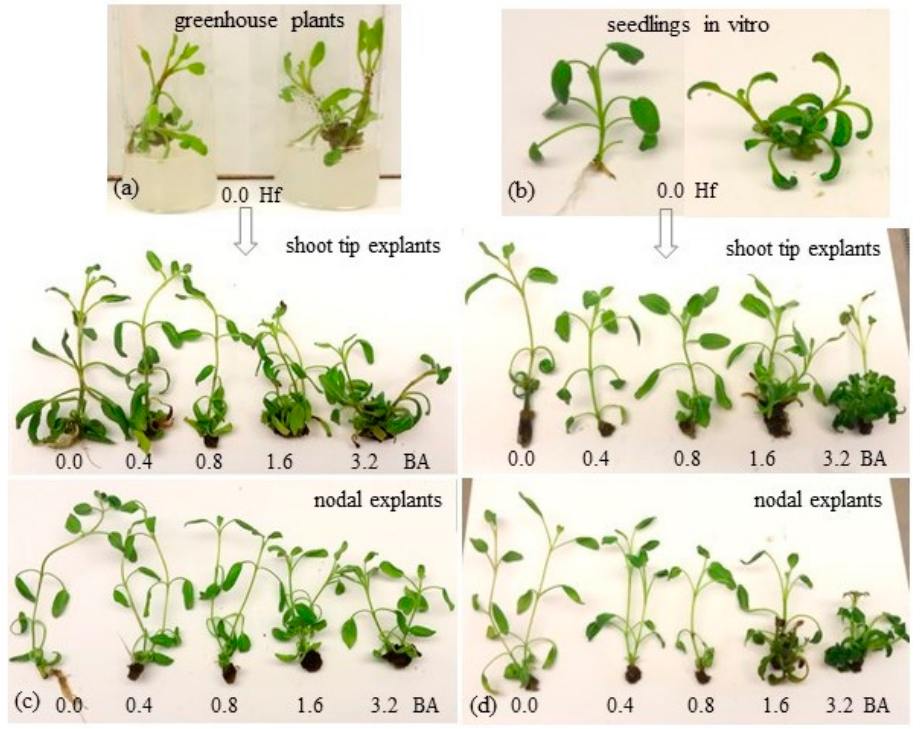
Figure 1. Typical response of S. tomentosa shoot tip (left) and single-node (right) explants excised from greenhouse adult plants ( a ) and in vitro seedlings ( b ), at the in vitro establishment stage in a hormone-free (Hf) MS medium; axillary shoot proliferation of shoot tip and single-node explants of greenhouse adult plants ( c ) and in vitro seedlings ( d ) origin, at a subculture on MS medium without plant growth regulators (0.0) or supplemented with 0.4 to 3.2 mg L − 1 BA and 0.01 mg L − 1 NAA.